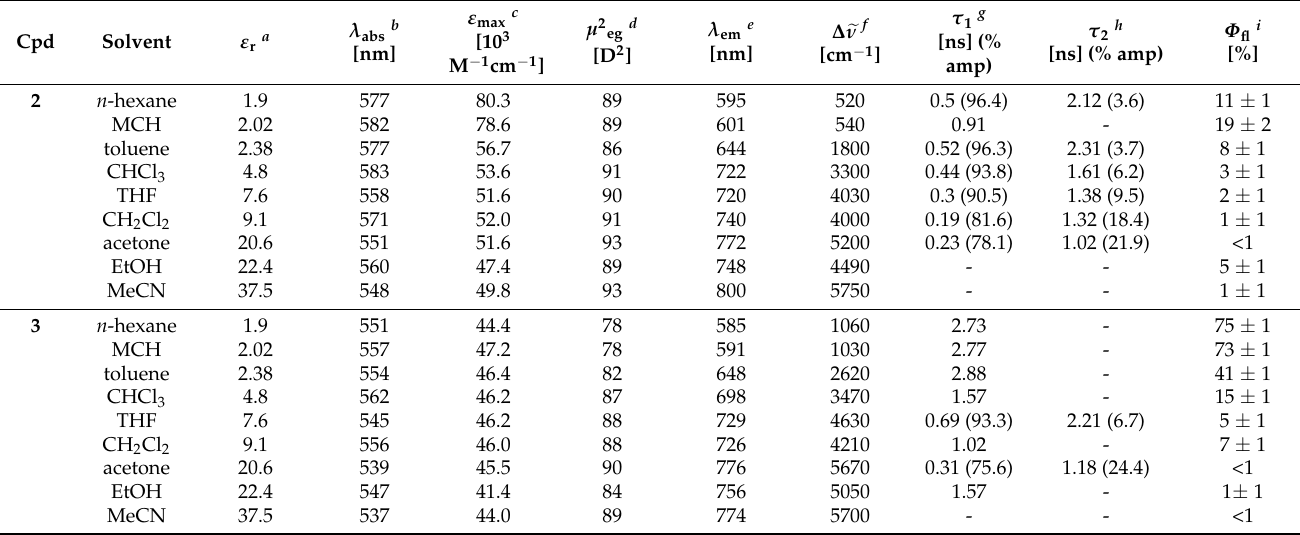
Table 2. Optical properties of D- π -A compounds 2 and 3 in solvents of varied